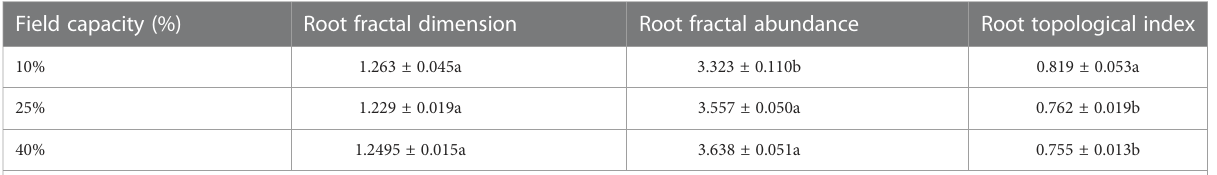
TABLE 1 Effects of different soil moisture on root fractal dimension, root fractal abundance and root topological index of K. hirsuta .